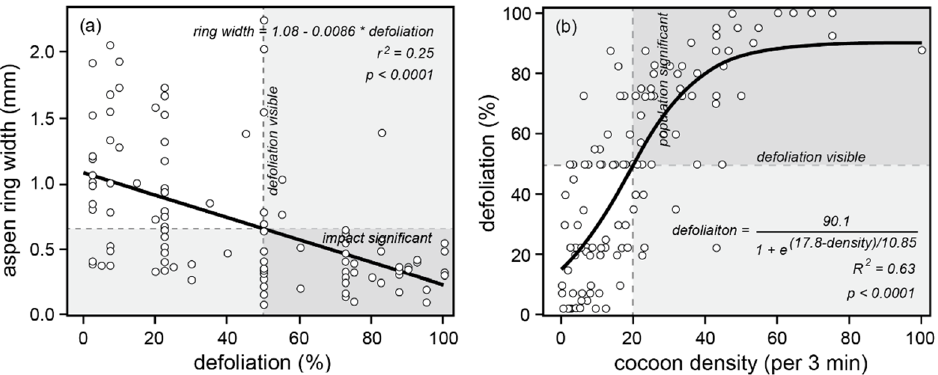
Figure 7 . Cooking Lake, Alberta population, defoliation, and impact data from 1995. The region from 50% to 100% defoliation is shaded and labelled “defoliation visible”. The upper branches of the impact curves ( a , b ) are also shaded, from the point at which defoliation exceeds 50%: 0.65 mm and lower in the case of ( a ), and 20 cocoons per 3 min and higher in ( b ). The dark shaded quadrants indicate the region of intersection where defoliation is visible and population impacts are “significant”. In contrast, the opposing unshaded quadrants indicate where defoliation is not visible and population impacts are not significant.